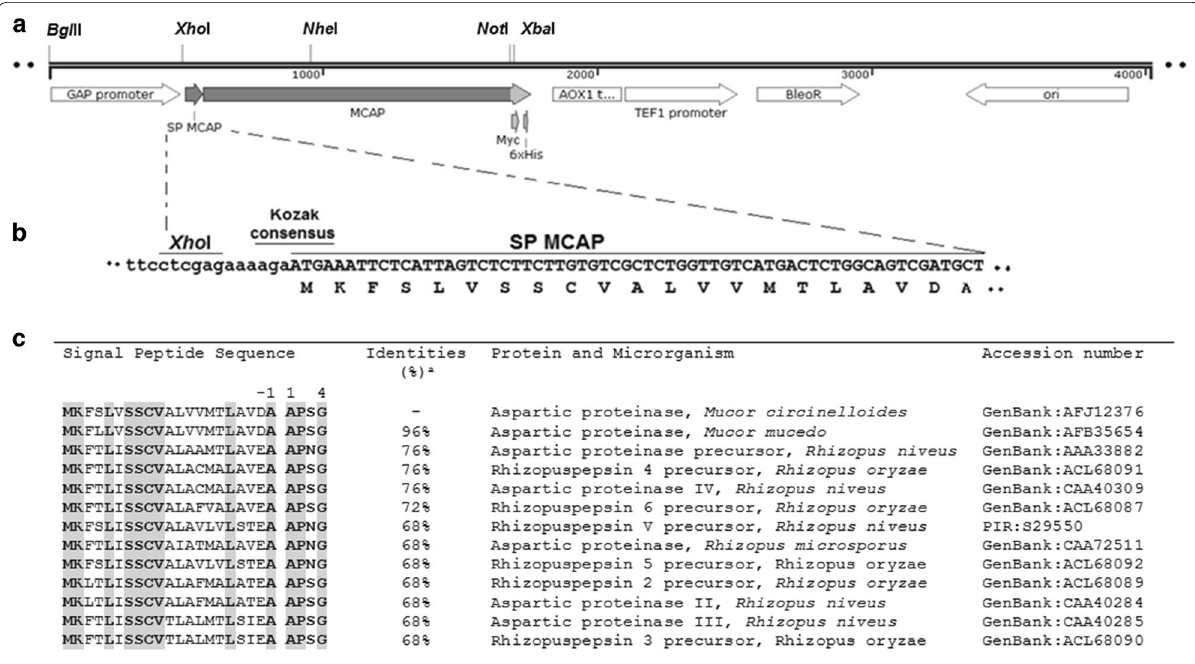
Fig. 1 Recombinant plasmid construction pGAM1 consensus located between the GAP promoter and the SP MCAP sequence of pGAM1 MCAP) of M. circinelloides with other fungal counterparts. The residues are numbered according to the signal sequence cleavage (between position 1 and 1: A‑AP). The residues identical are shaded in −